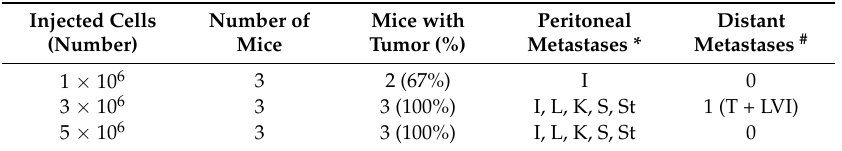
Table 1. Optimization of cell titre for tumour